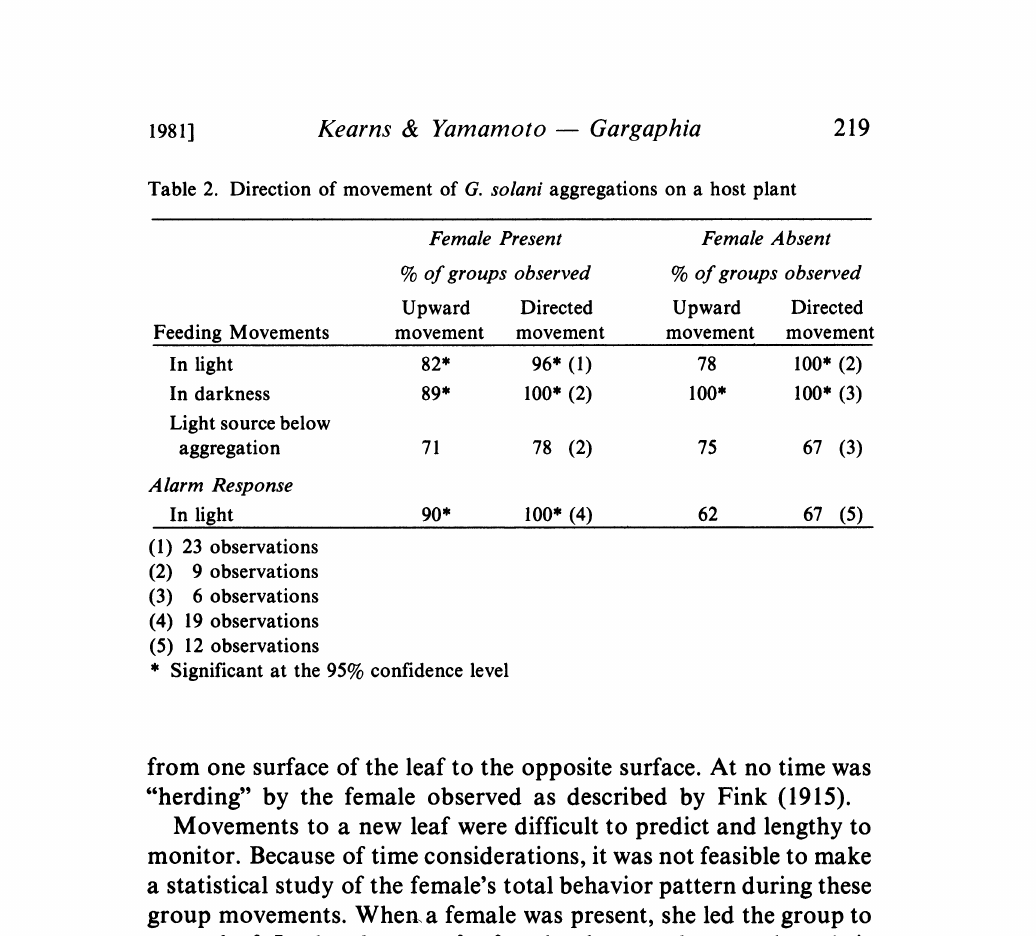
Table 2. Direction of movement of G. solani aggregations on a host